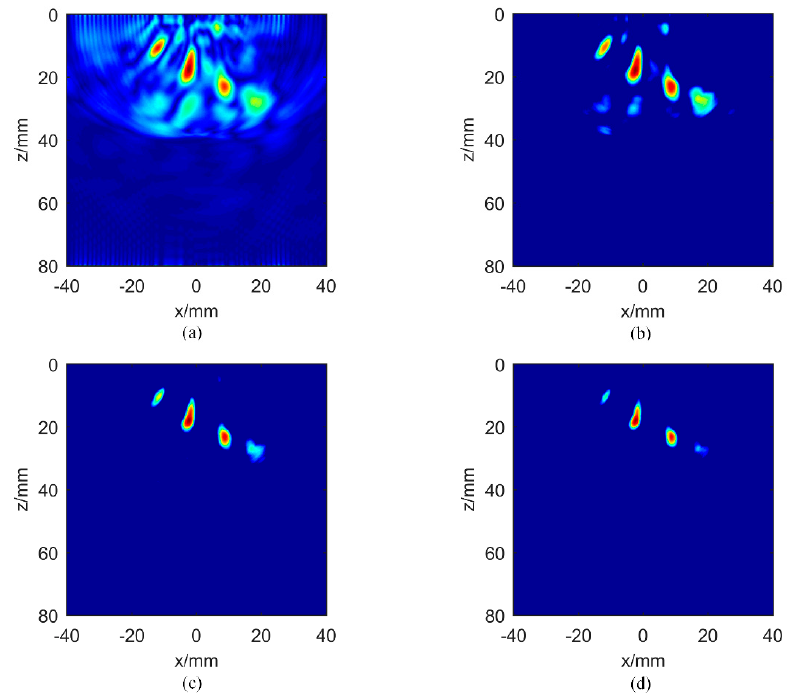
Figure 8. E ff ect of variable σ on imaging for aluminum plate B: ( a ) σ = 0; ( b ) σ = 0.5; ( c ) σ = 1; ( d ) σ =